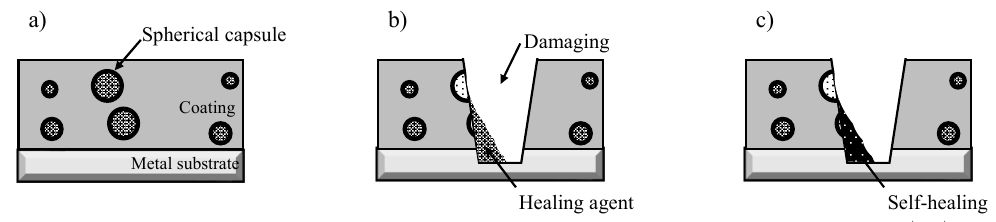
Figure 12. Schematic illustration of the structural change of SHC-SC by physical damaging. ( a ) Just before damaging, polyurethane coating with dispersed spherical capsules. ( b ) Just after damaging, flowing-out of healing agent from broken capsules to damaged area. ( c ) At the last stage of aging, repairing the coating at part of the damaged area with a self-healing structure.